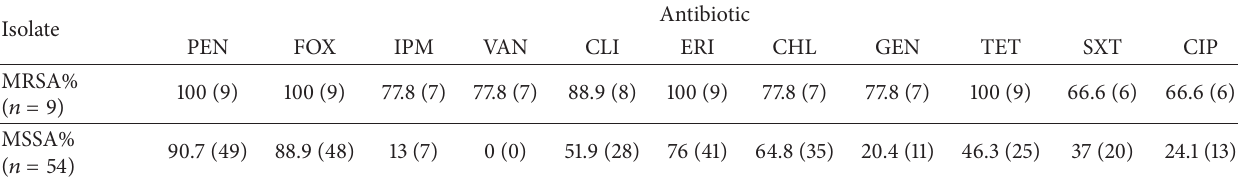
Table 3: Frequency of MRSA and MSSA strains according of antibiotic susceptibility patterns. Isolate